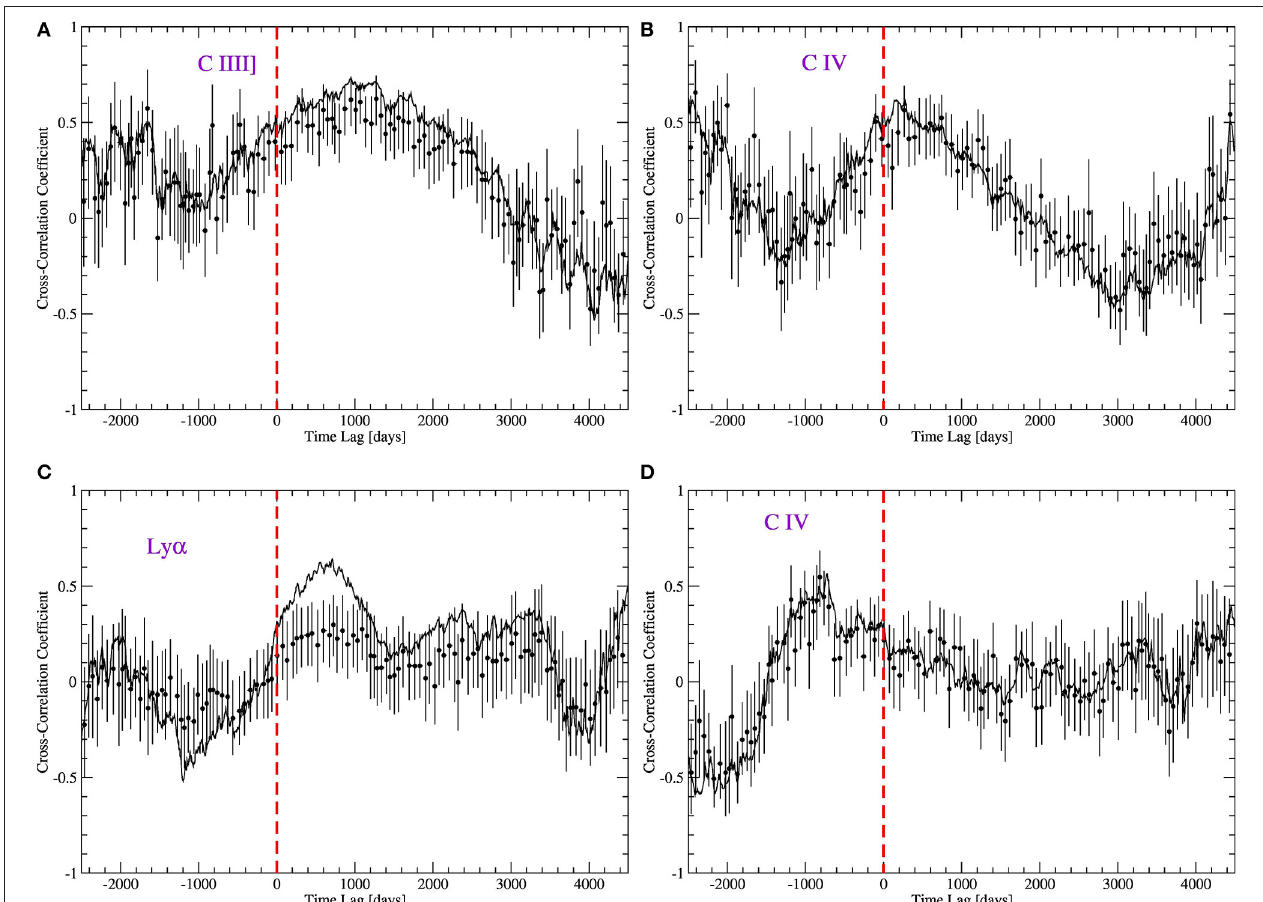
FIGURE 3 | CCFs for the light curves shown in Figures 1 , 2 . (A,B) are the CCFs of Ly α and C IV vs. the continuum of SBS1233 + 594. (C,D) are the CCFs of Ly α and C IV vs. the continuum of SBS1233 + 594. The ICCF method is shown as a solid line and the ZDCF method is shown as filled circles with uncertainties. Time lags are given in the observed